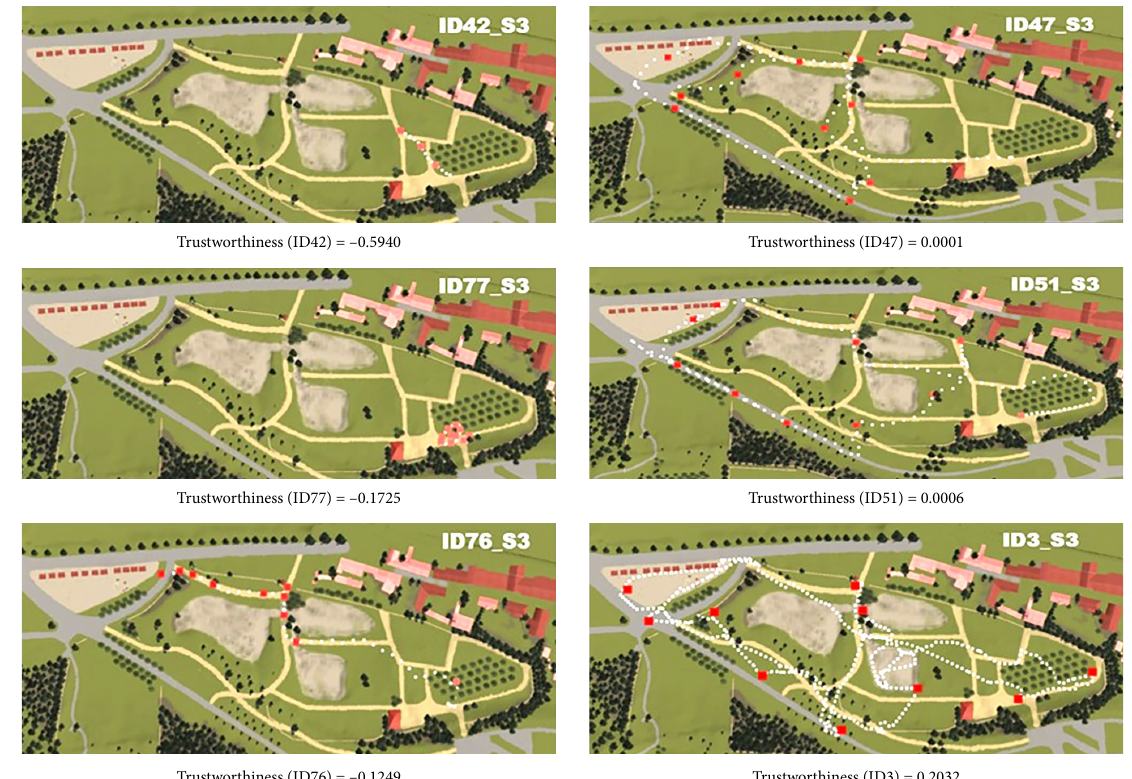
Figure 8. The behaviour of the selected respondents that played Scenario 3 in the game-based survey